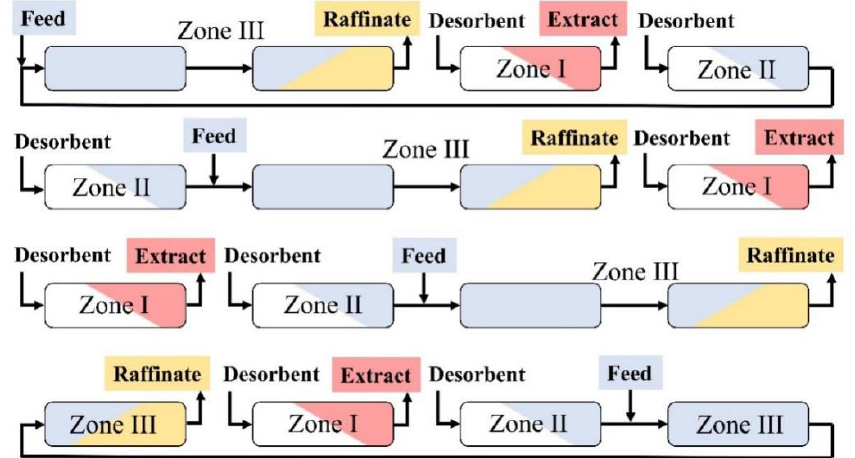
Figure 7. Schematic diagram of three-zone SMB (with 1-1-2 column distribution).